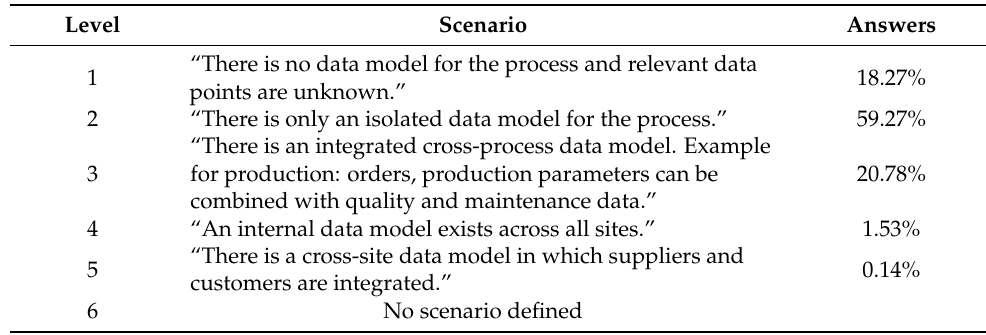
Table 3. Results for the capability “data model”.